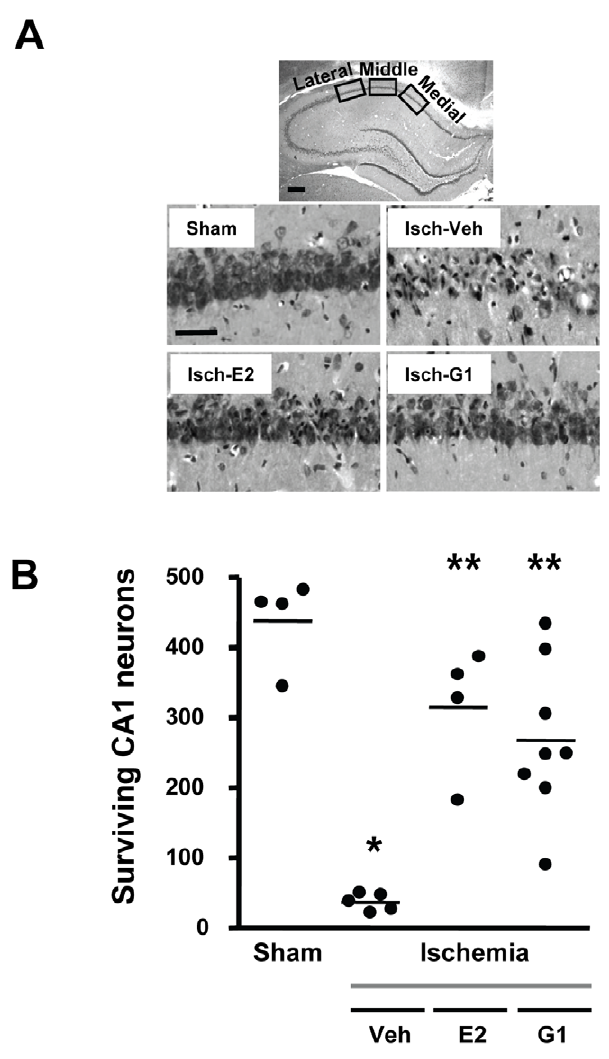
Figure 2. G1 and E2 afford similar levels of neuroprotection when administered to young rats immediately after ischemia. Panel A shows representative photomicrographs of hippocampal neurons in the dorsal CA1 region 7 days after sham surgery or global ischemia (Isch) in young adult female rats that were OVX for 1 week and injected ICV with either E2 (2.25 m g), G1 (50 m g) or vehicle (DMSO) immediately after ischemia. Scale bars: low magnification, 400 m m; higher magnification, 60 m m. Panel B: Quantification of living pyramidal neurons was performed in the CA1 region of the hippocampus 7 days after ischemia. Neurons were counted in 3 sectors (lateral, middle and medial) of the dorsal hippocampus. ANOVA followed by Newman Keuls, * p , 0.001 versus sham, ** p , 0.001 versus ischemia/vehicle.